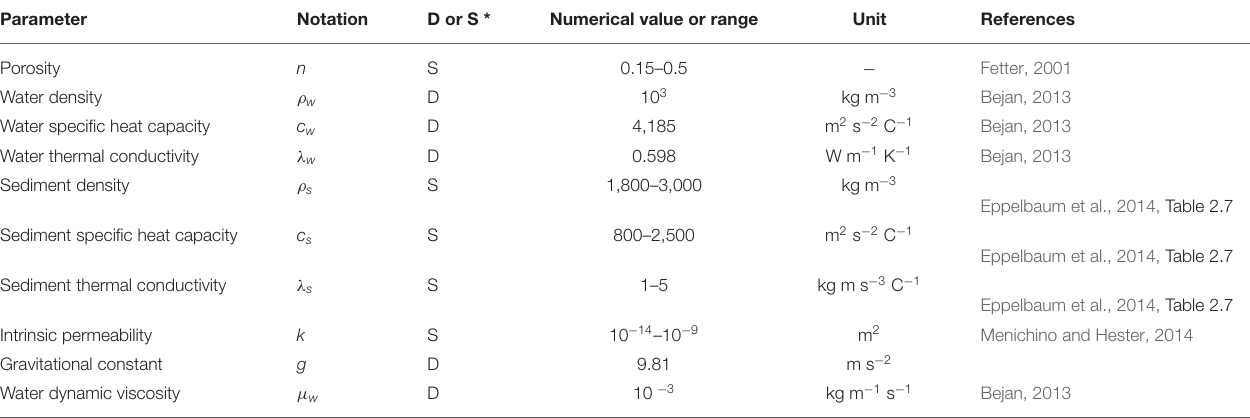
TABLE 2 | HZ properties in the process-based